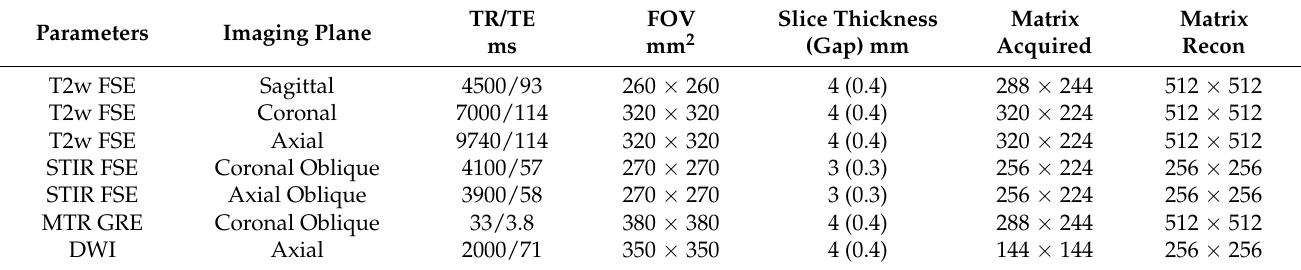
Table A1. MRI sequence parameter information for 1.5 T GE scanner (Nottingham site).